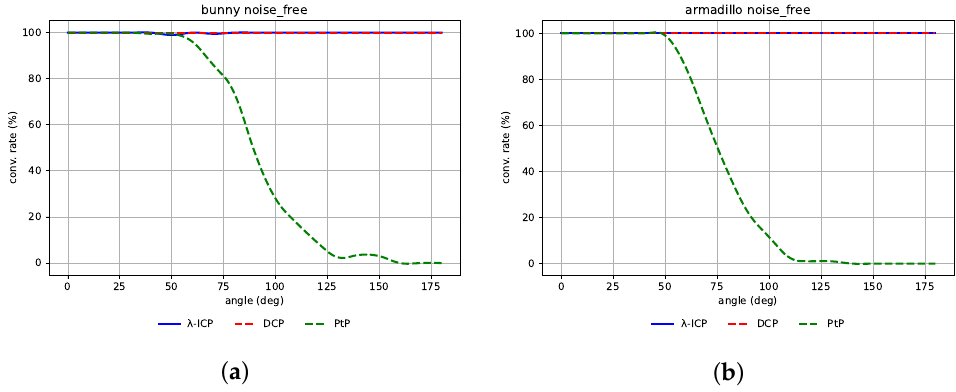
Figure 4. Convergence rate of λ -ICP (blue), DCP (red), PtP (green) algorithms for: ( a ) Stanford Bunny; ( b ) Armadillo.